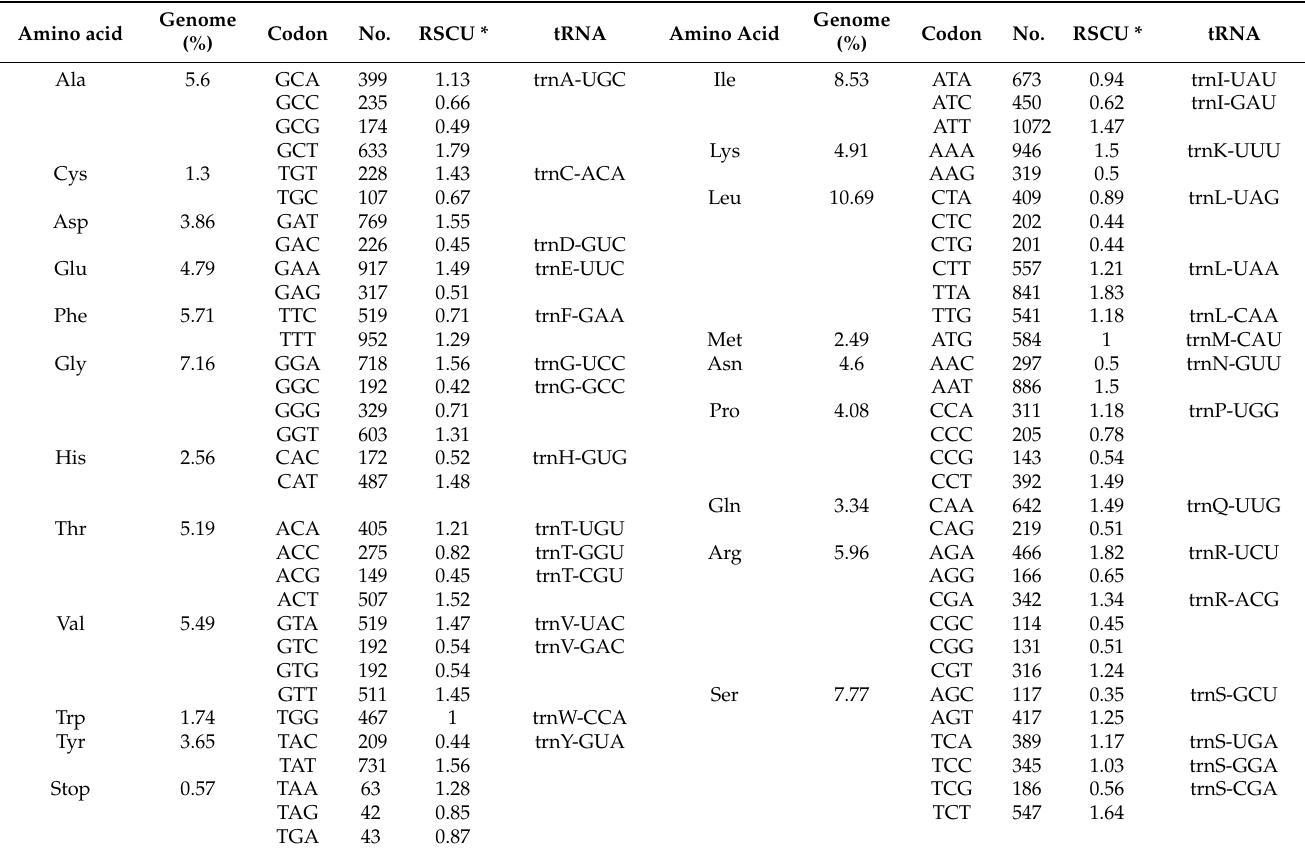
Table 5. Frequency and patterns of codon usage and codon–anticodon recognition in the chloroplast genome of P. vera